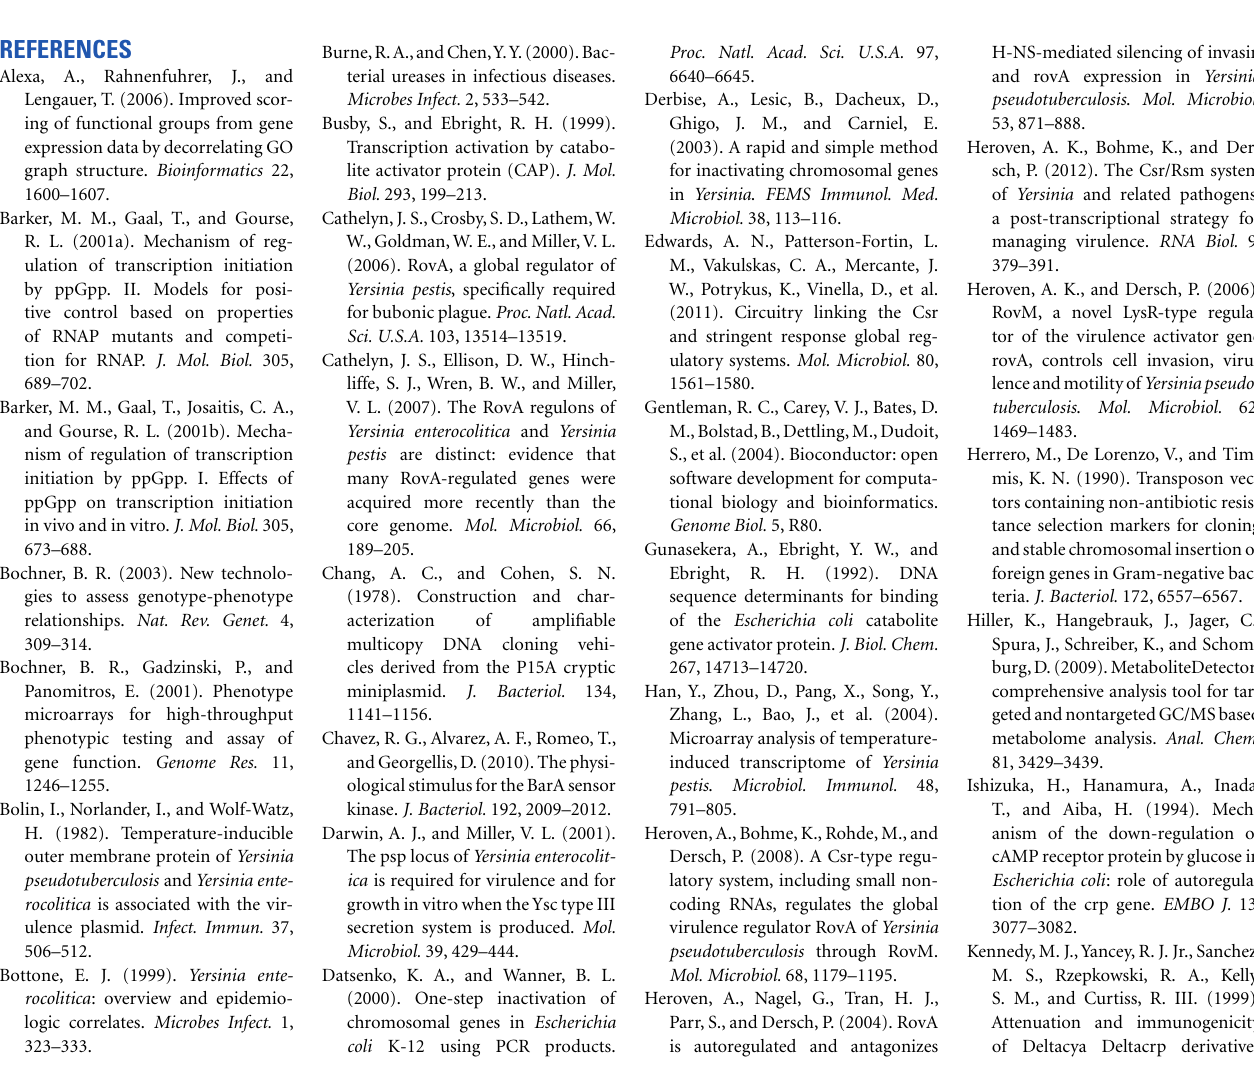
Table S1 | Changed metabolites between Y. pseudotuberculosis YPIII and the crp mutant. Table S2 | Classification of Crp-dependent genes. Table S3 | qRT-PCR of Crp target transcripts. Table S4 | Bacterial strains and plasmids. Table S5 | Oligonucleotides used in this